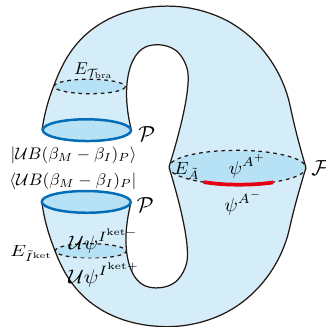
( A ∪ I ket : a I ) |U ψ I ket − , ψ A + i ket